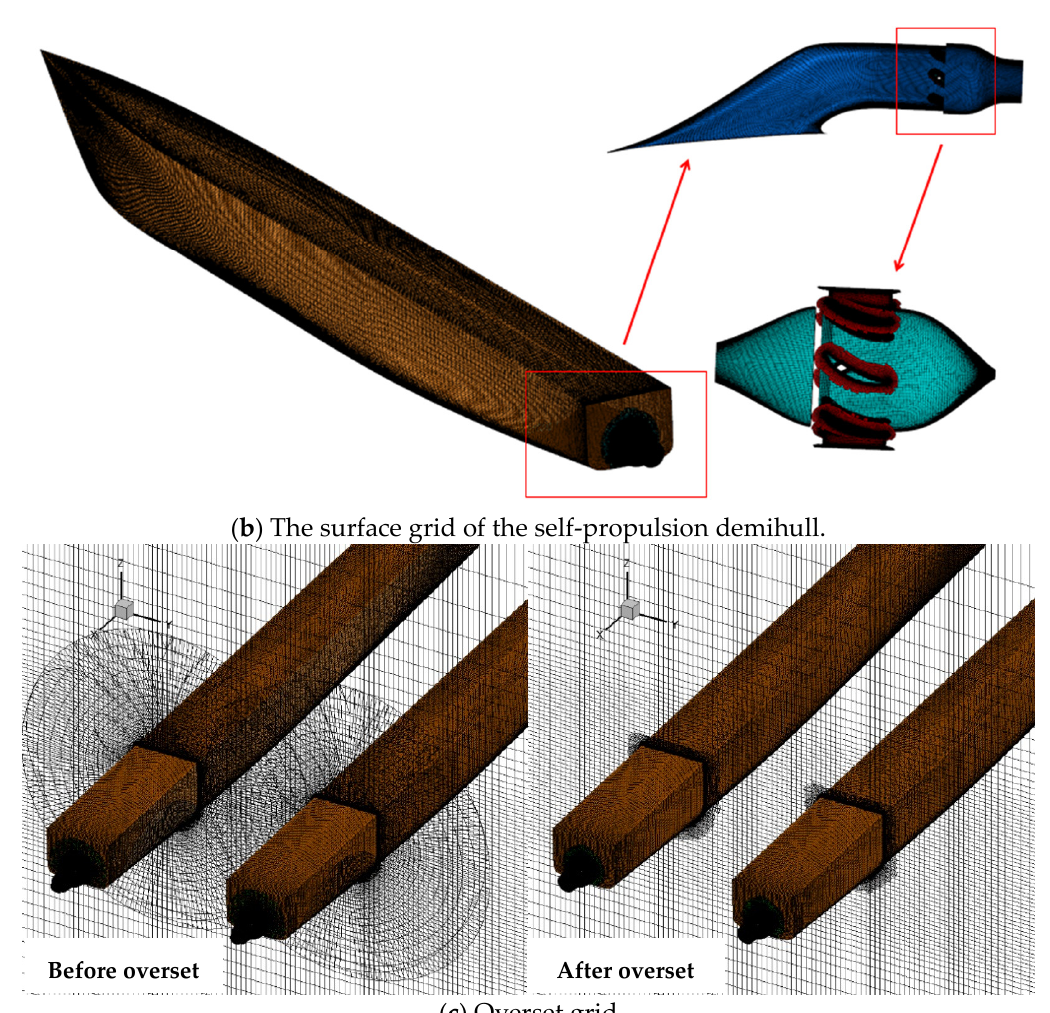
Figure 6. Overset grid of the self-propulsion demihull.